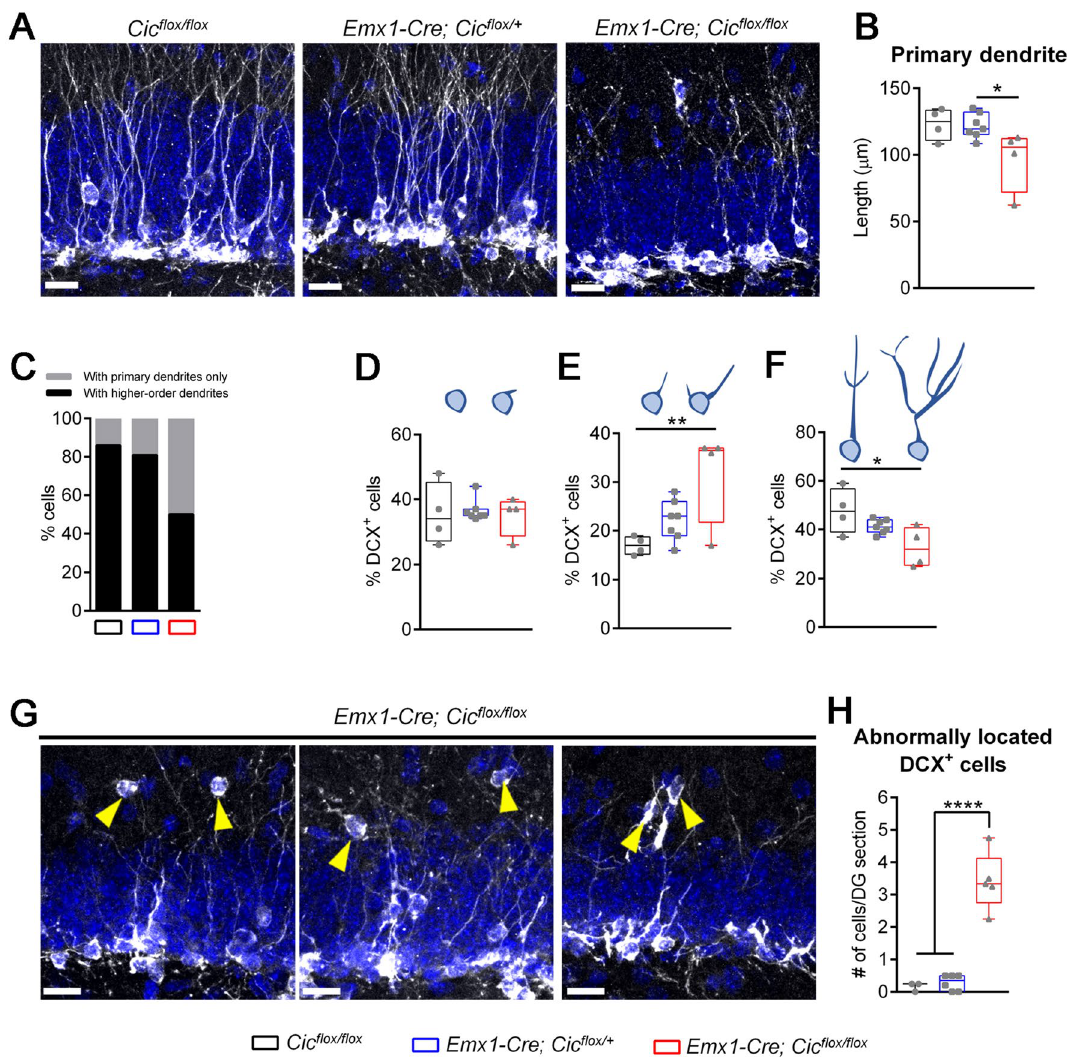
Figure 4. Reduced dendritic branching and abnormal migration of DCX + cells in the Emx1-Cre Cic knockout mice. ( A ) Representative images of the dentate gyrus show abnormal dendritic morphology in knockout DCX + cells. DAPI (blue) and DCX (grey). ( B ) Quantification of primary dendrite length. ( C ) Dendrite analysis shows reduced dendritic complexity in the knockout mice. P < 0.0001 using Chi-square test. ( D – F ) DCX + cells are categorized into distinct subgroups based on their dendrite morphology. The Emx1-Cre Cic knockout mice show no difference in the number of the most immature subgroup with no or short processes ( D ), an increase in the intermediate subgroup with a medium-length process ( E ), and a decrease in the most mature subgroup with a thick long apical dendrite or an elaborate dendritic tree ( F ). ( G ) Representative images of the dentate gyrus show ectopically located DCX + cells in the Emx1-Cre Cic knockout mice. Each image is from a different animal. DAPI (blue) and DCX (grey). ( H ) Quantification of abnormally located DCX + cells. N = 3 ‒ 6 animals per group. Scale bars = 20 µm. Data are presented in box-and-whisker plots showing all data points, where centre lines represent medians, box limits represent interquartile ranges, and whiskers represent minimum to maximum data ranges. Statistical analyses were performed with one-way ANOVA with Tukey’s post hoc test. * P < 0.05; ** P < 0.01; **** P < using a single-cell RNA sequencing dataset of the adult dentate gyrus 6,30 . This analysis revealed only two candi- dates, Nfia and Nfib , which are both members of the nuclear factor I (NFI) family (Supplementary Fig. S9 and S10). By co-staining NFIA and NFIB with cell-stage specific markers, we confirmed that both NFIA and NFIB were most highly expressed in DCX + cells, with NFIB experiencing a greater increase in expression from the transition of SOX2 + neural progenitor cells to DCX + cells (Supplementary Fig. S9 and S10). Moreover, within the DCX + population, strong NFIB expression was seen in majority of the cells except the ones with the most mature morphology, namely those with an elaborate dendritic tree, an enlarged cell body and low DCX expression 22,31,32 . As DCX + cells developed into mature neurons, NFIA and NFIB levels dropped. Thus, expression of NFIA and